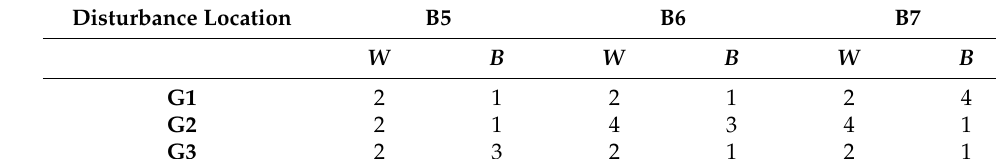
Table 10. Impact of disturbance location on the optimal values of W and B .